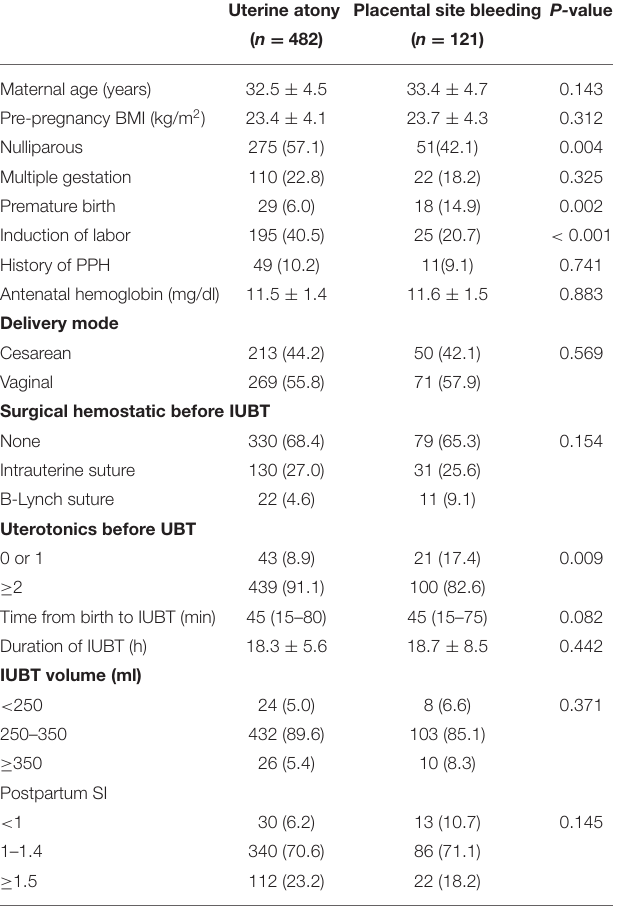
TABLE 2 | Outcomes of women with PPH treated by IUBT due to uterine atony or placental site bleeding. Uterine atony Placental site bleeding P-